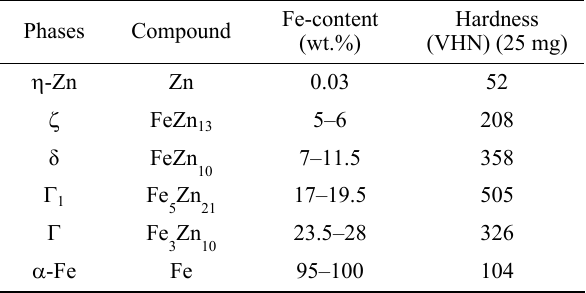
Table 2 Fe ‒ Zn phases, compounds, constituents, and hardness of the phases formed in Fe ‒ Zn system.